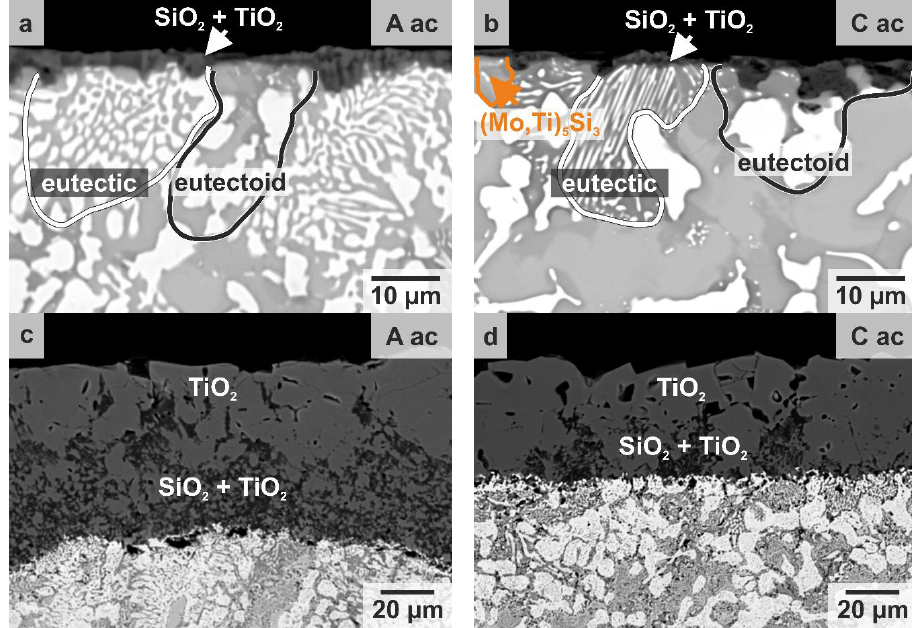
Figure 5. Cross-sectional BSE micrographs of the cyclically oxidized samples of alloy A ( a ) and C ( b ) at 800 °C after 100 h. Surface-near, characteristic regions below the oxide scale are labelled for the sake of clarity. Oxide scales formed after 100 h of cyclic oxidation at 1200 °C in air of alloy A ( c ) and C ( d ).